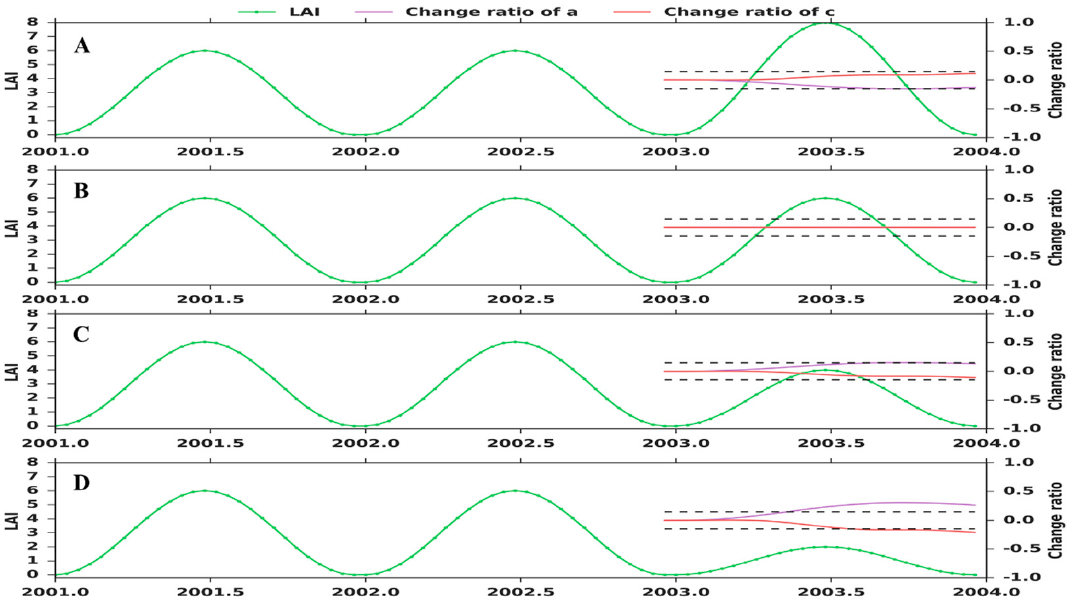
Figure 3. Using the season-trend model to simulate GLASS LAI time series compared to the previous two years LAI values in 2003. ( A ) multiplied the coefficient 4/3, ( B ) is 1, ( C ) is 2/3, and ( D ) is 1/3. Where the red line is the curve of the amplitude of the parameter c, the purple line is the amplitude curve of b.